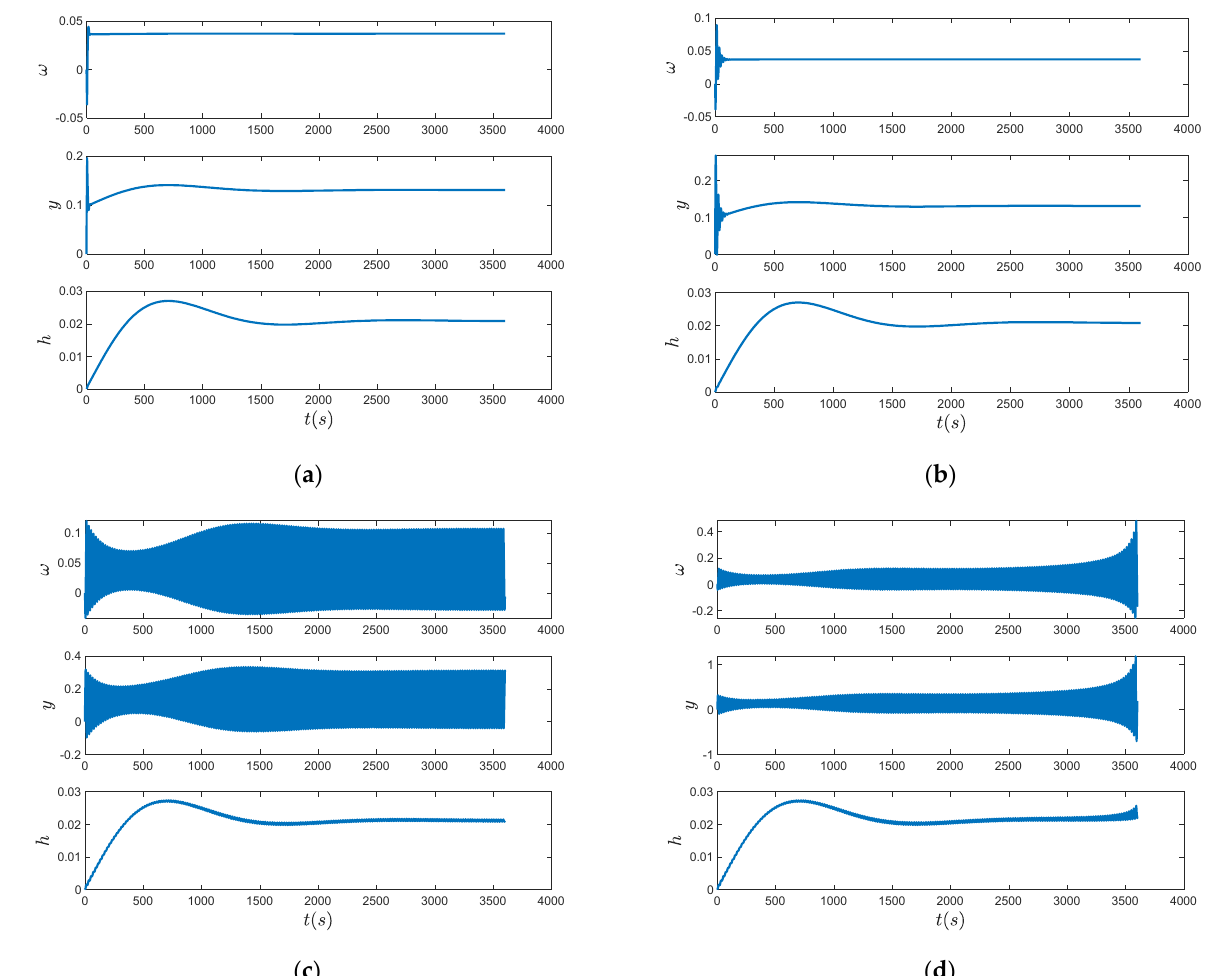
Figure 6. Dynamic responses of state variables x , y , ω for S 1 , S 2 , S 3 and S 4 . ( a ) S 1 ; ( b ) S 2 ; ( c ) S 3 ; ( d ) S 4 .